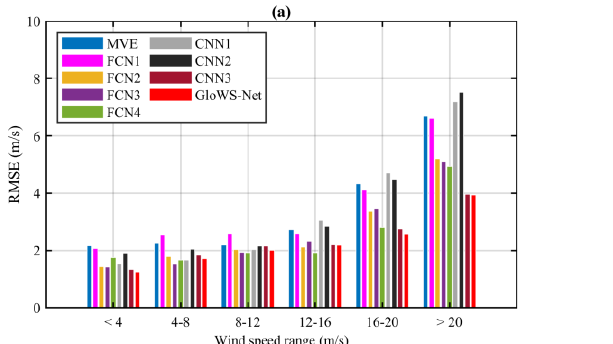
Figure 5. Scatter density plots of retrieved wind speed by different models and ERA5 wind speed.